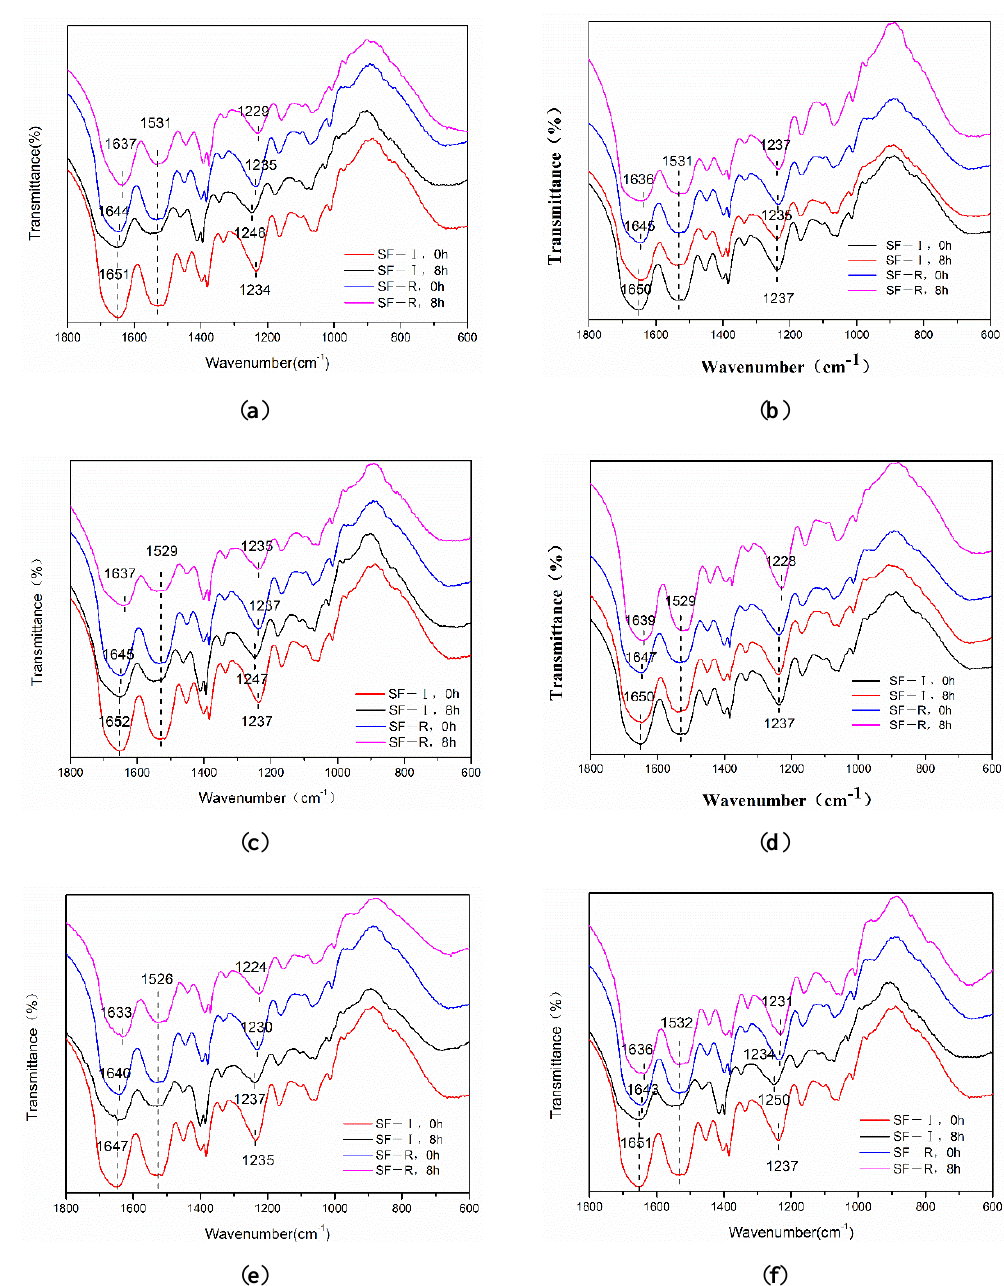
Figure 3. Fourier transform infrared spectroscopy (FTIR) spectra of SF-I and SF-R materials before and after alcohol treatment: ( a ) 75% methanol, ( b ) 90% methanol, ( c ) 99% methanol, ( d ) 75% ethanol, ( e ) 90% ethanol, ( f ) 99% ethanol.